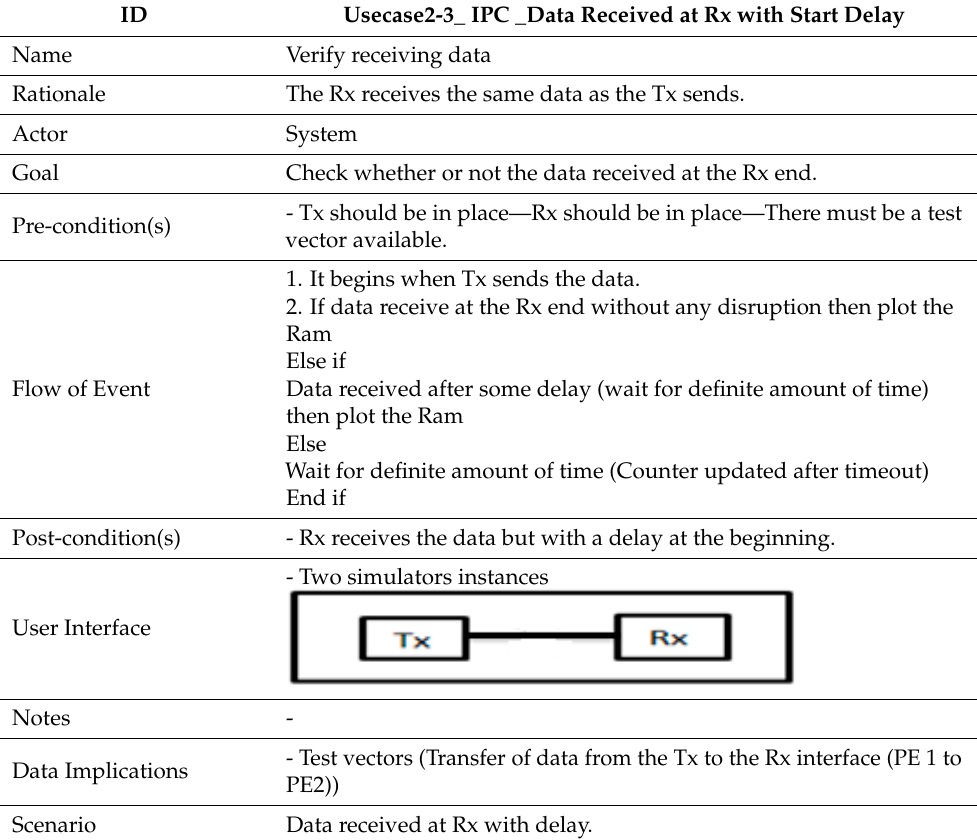
Table 2. Use case “data received at Rx with delay (start)”.